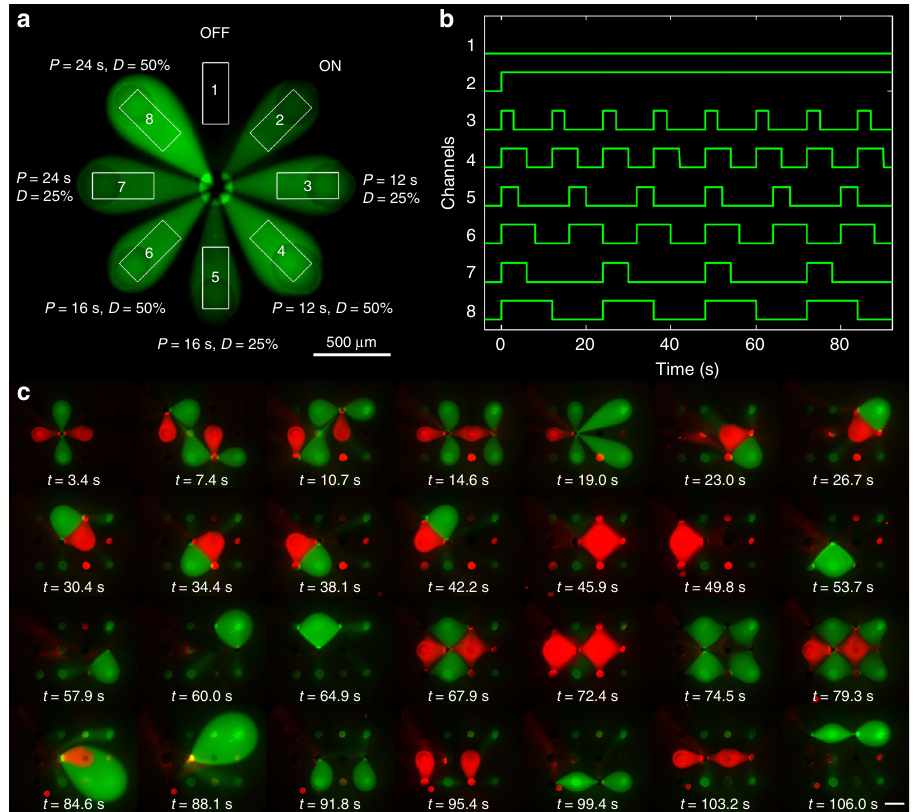
Fig. 4 Micro fl uidic multipole devices. a Fluorescence micrograph showing the con fi nement pattern of a rMFM device. b Graph representing the periodic exposure to reagents for each con fi nement area of a rMFM used as a chemical stroboscope. c Fluorescence micrographs showing 28 different con fi nement patterns made with a 12-aperture tMFM during a single experiment lasting less than 2 min. Scale bar represents 500 µ